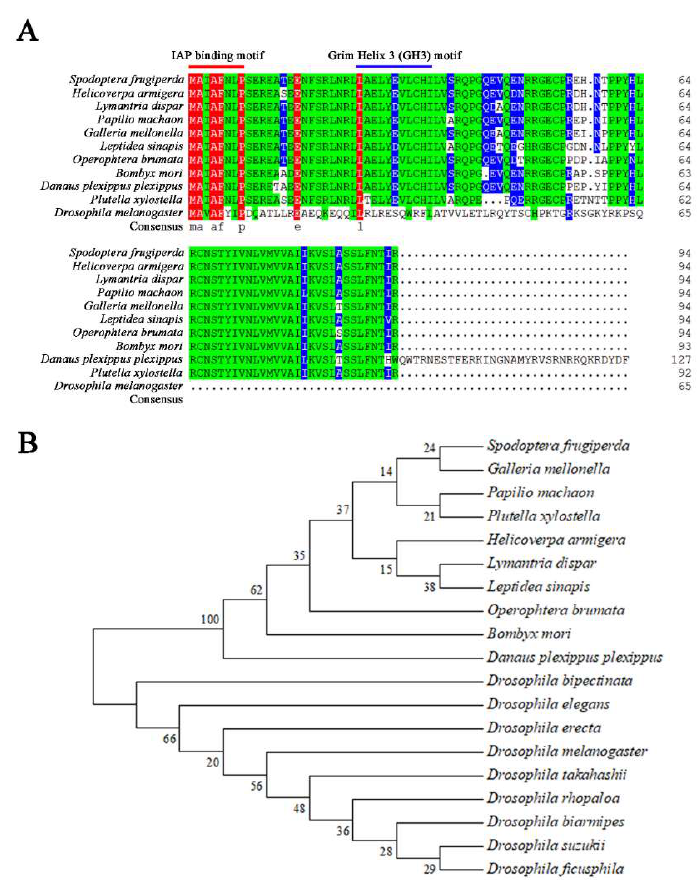
Figure 1. Sequence similarity among IBM1s from different insects. ( A ) A multiple sequence alignment of Sf-IBM1 together with IBM1s from other insects. GeneBank accession numbers of IBM1s